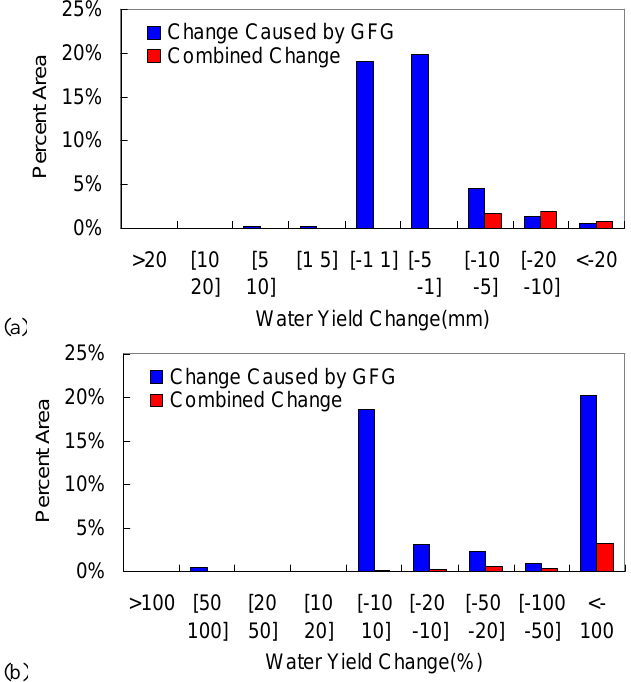
Fig. 6. (a) Frequency distribution of significant water yield change per year and (b) its relative value. Fig. 6 Frequency distribution of significant water yield change per year (a) and its relative